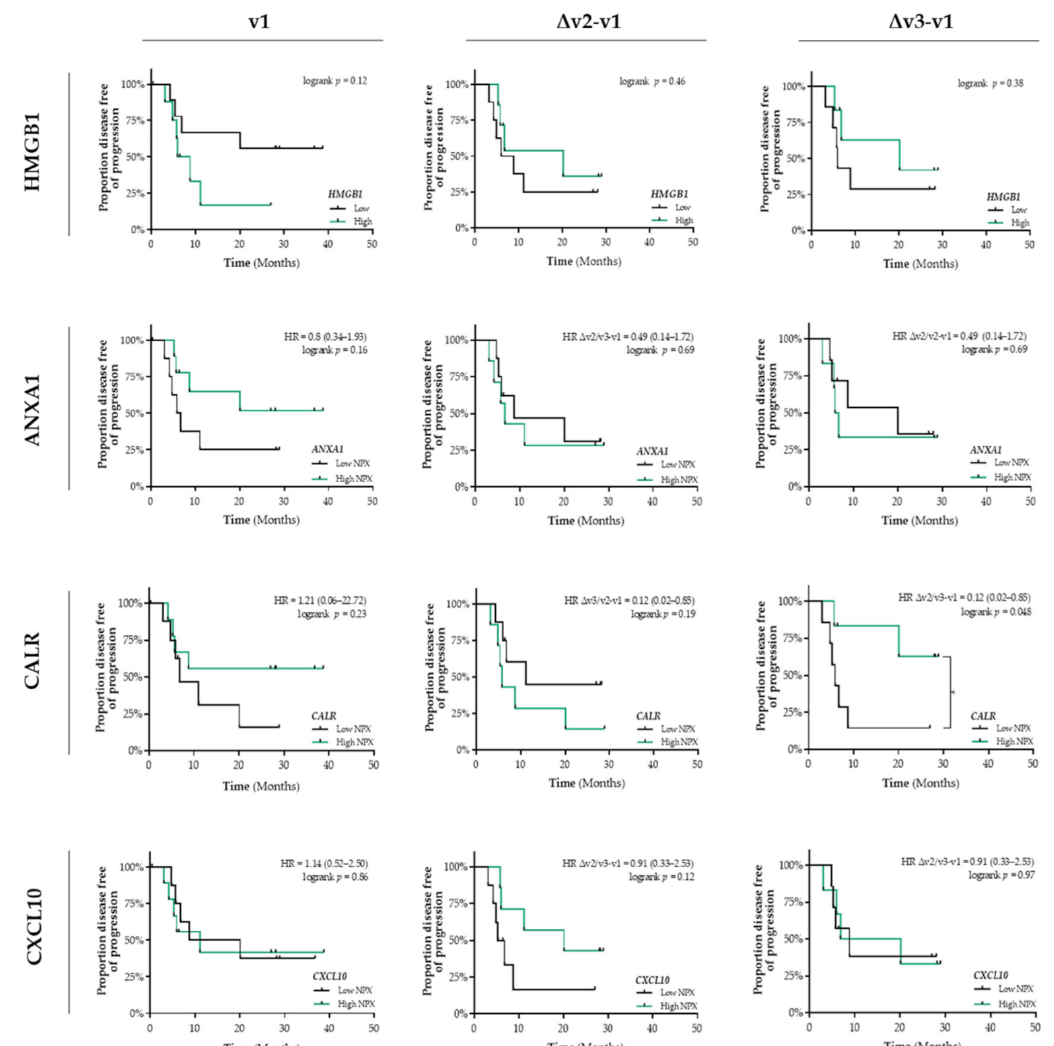
Figure 3. Detection of immunogenic cell death-related proteins in the circulation of patients with stage III NSCLC treated with CCRT. Circulating levels of immunogenic cell death (ICD)-related proteins in patients with stage III NSCLC ( n = 18) at baseline (v1), after the 3rd fraction of RT (v2), after the final fraction of RT (v3) were assessed by ELISA (HMGB1) or by the Proximity Extension Assay from Olink (ANXA1, CALR, and CXCL10). Patients were stratified into low (black lines) or